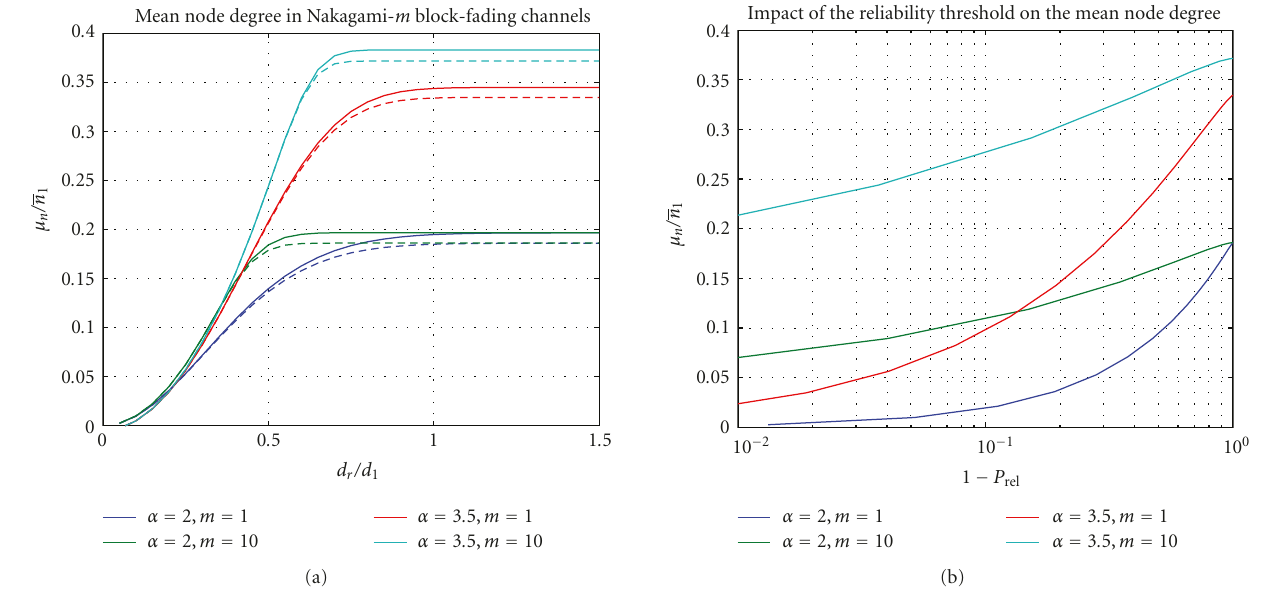
Figure 8: Mean node degree estimation for a BPSK modulation ( k = 1), with N b = 1000 bits, plotted as a function of the reliability range, d r in (a), and the limit transmission error probability a di ff erent power detection threshold ε d ll (cid:13) ε d (plain) and ε d = (cid:13) ε d (dotted curves). In (b), the connectivity loss owing to a reliability threshold is plotted. For instance, a reliability need of P err (tr) < 10% would make the mean node degree decreasing from 0 . 2 to 0 . 015 with m = 1 and α =